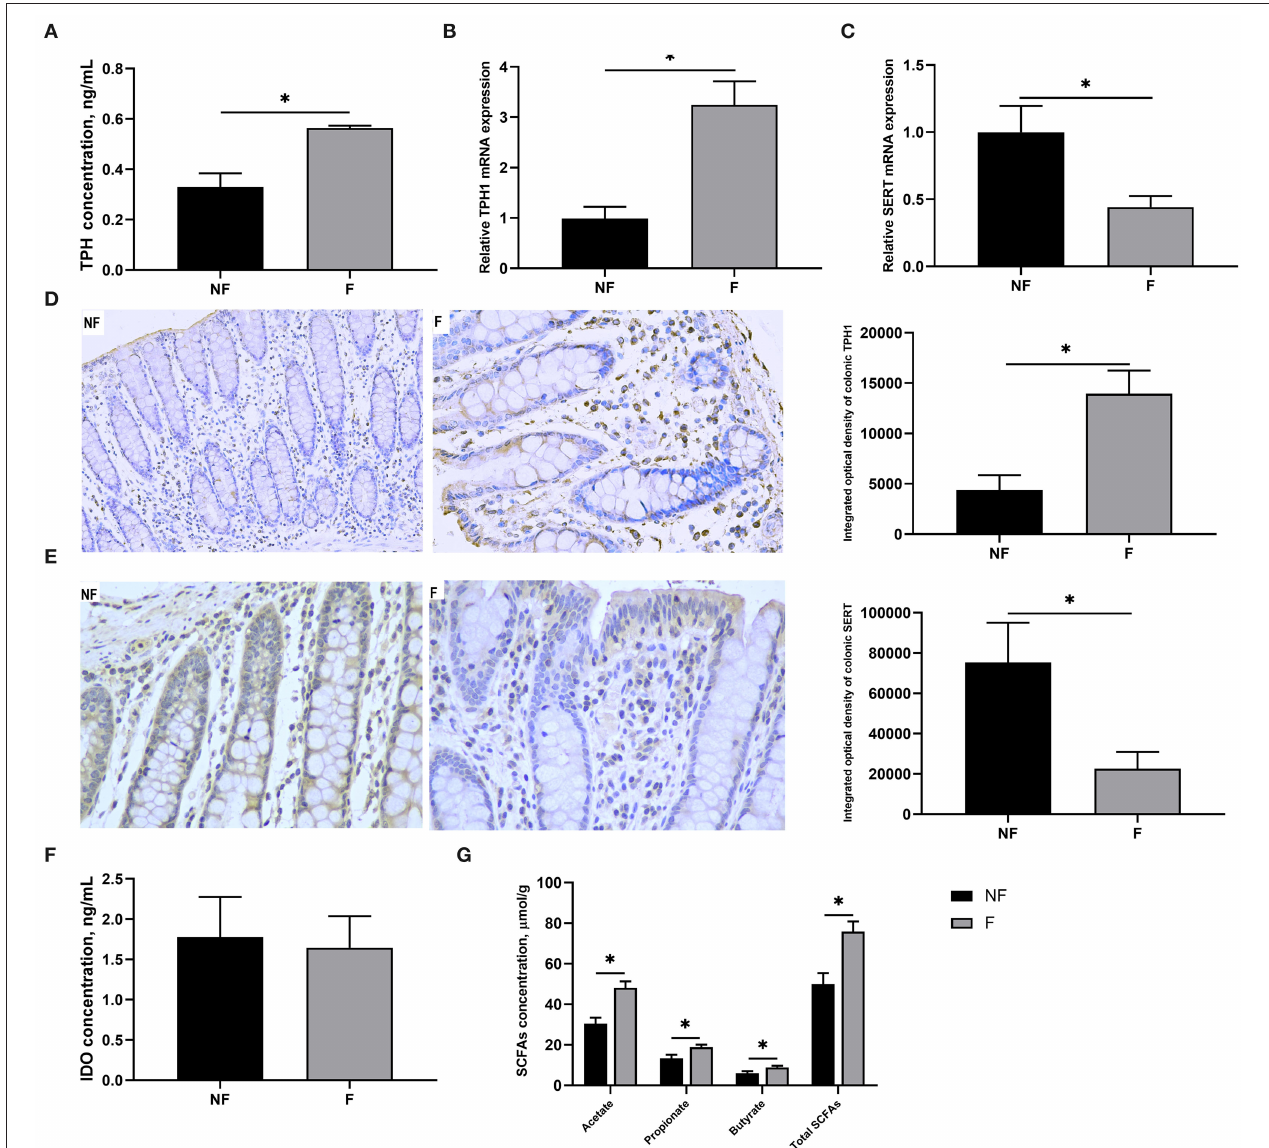
FIGURE 3 | Effects of fiber supplementation in gestation diet on serotonin synthesis and transport in sow colon. (A) TPH concentration; (B,C) Gene expression of TPH1 and SERT; (D,E) Protein expression of TPH1 and SERT measured using immunohistochemistry; (F) IDO concentration; (G) SCFAs concentration. NF, sows fed with a semi-purified basal diet (0.01% dietary fiber); F, sows fed with a semi-purified basal diet supplemented with 8.33 g/kg inulin and 200 g/kg cellulose. TPH, tryptophan hydroxylase; SERT, serotonin transporter; IDO, indoleamine-2, 3-dioxygenase; SCFAs, short-chain fatty acids. Values are mean ± standard error ( n = 5). Significant differences are displayed in the figures by * P <